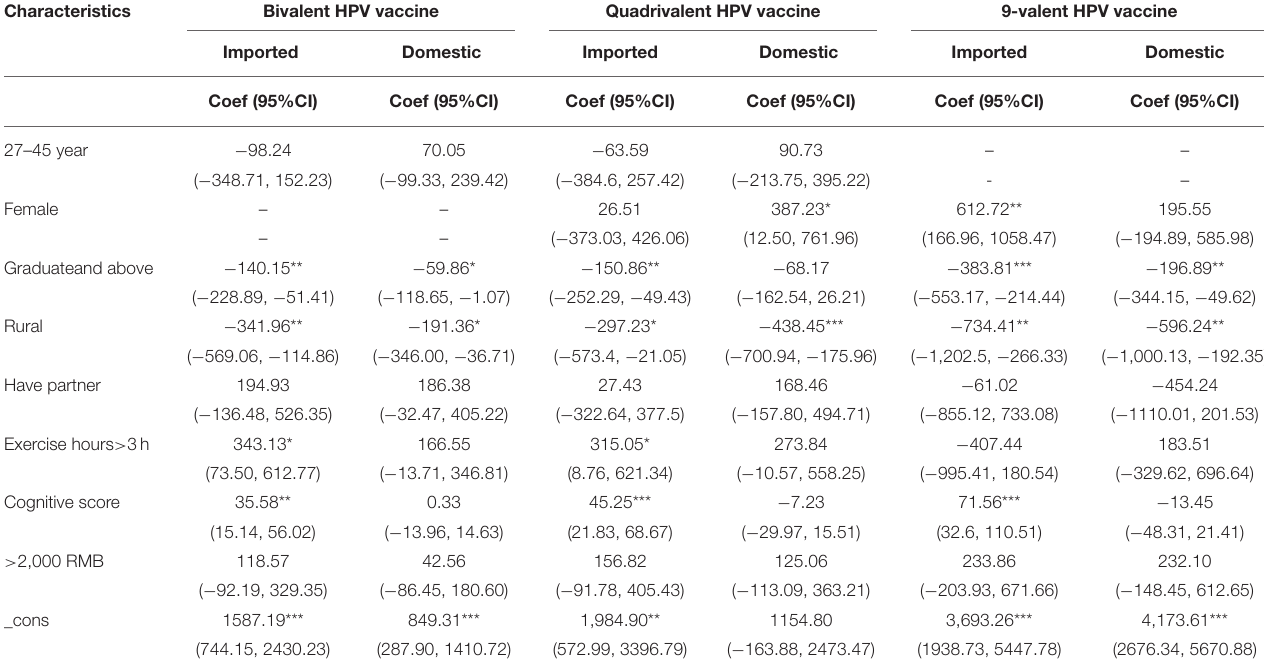
TABLE 5 | Tobit model of WTP for HPV